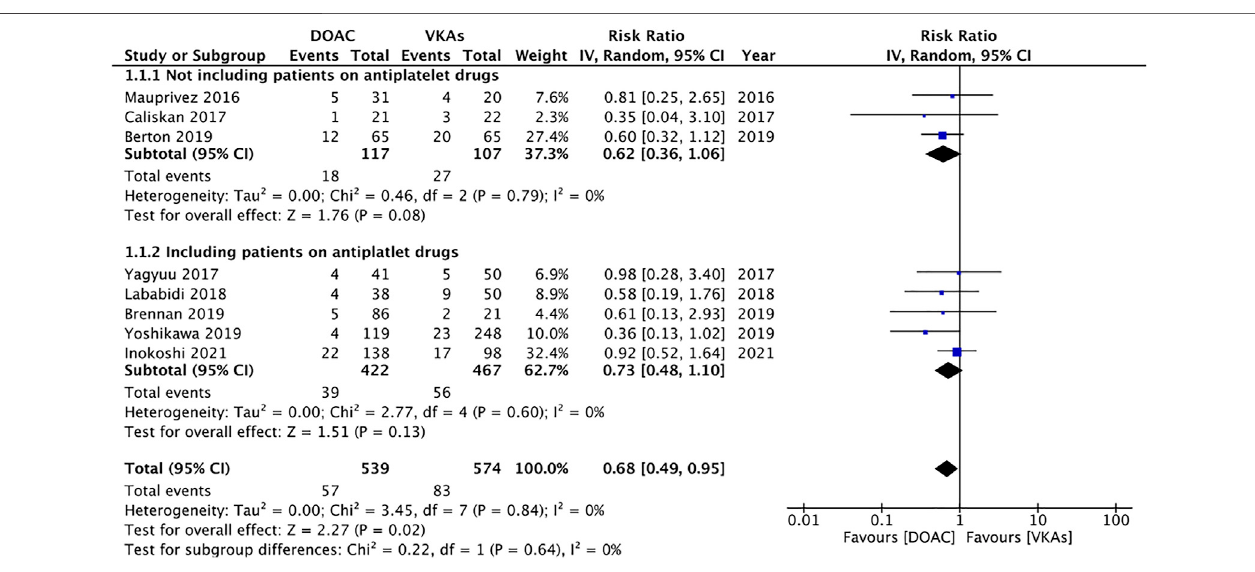
FIGURE 2 | Meta-analysis of bleeding outcomes between patients under DOAC vs. VKAs with subgroup analysis based on inclusion of patients on antiplatelet drugs.